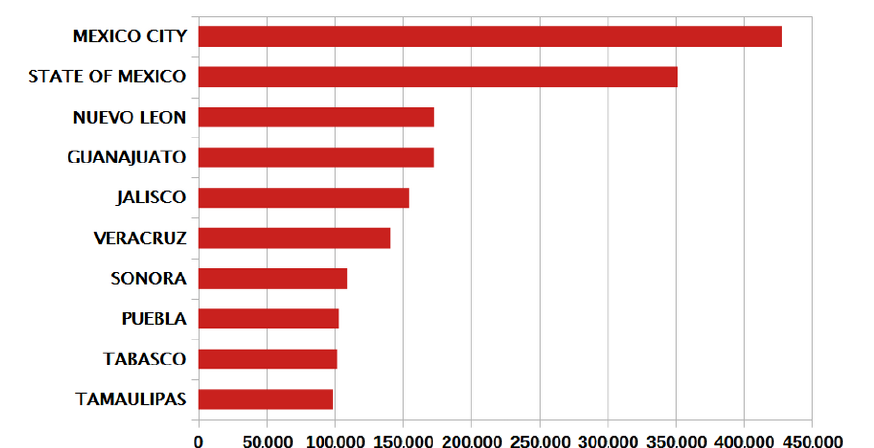
Figure 4. Mexican states with most COVID-19 cases from February 2020 to April 2022.